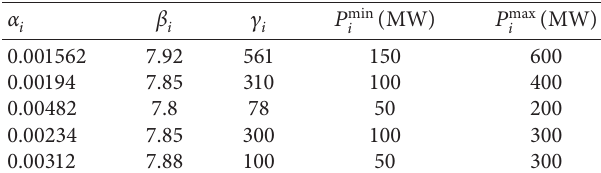
Figure 2: IEEE 57-bus Table 1: Parameters of generators. Table 2: Initialization.